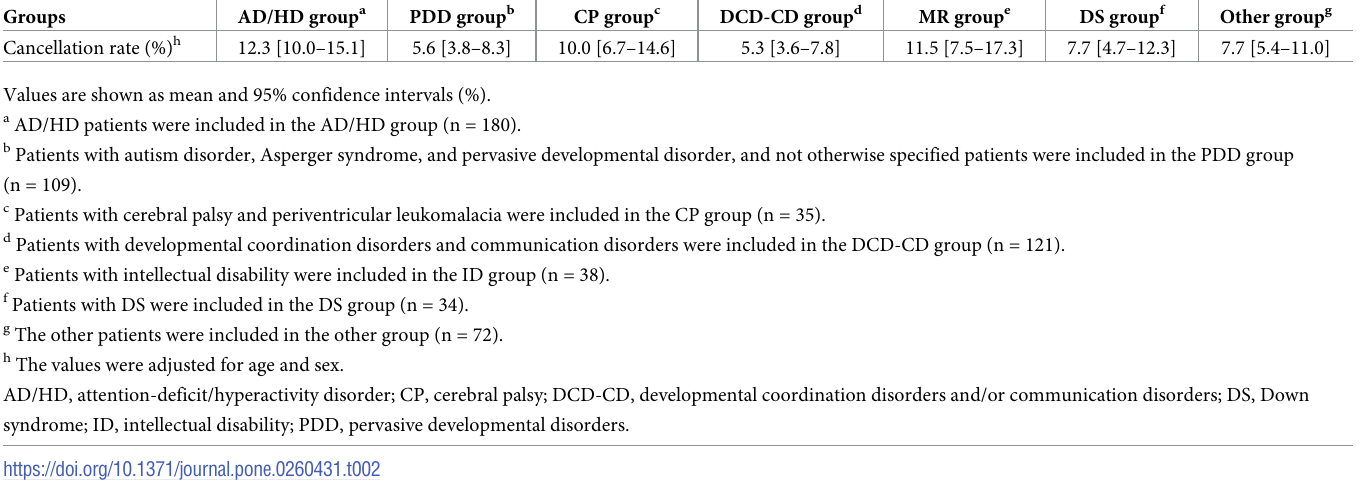
AD/HD group was significantly higher than that in the PDD or DCD-CD groups (Table 3 and Fig 1). The cancellation rate in the AD/HD group was numerically higher than that in the other four groups, although the difference did not reach statistical significance (Table 3 and Fig 1).